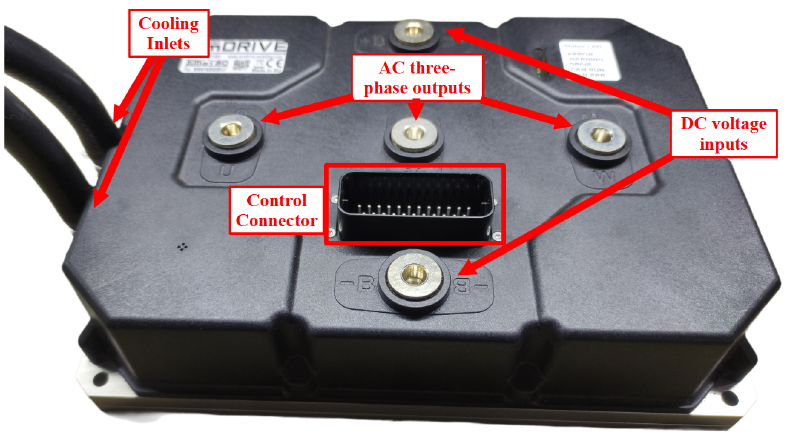
Figure 11. emDrive 500 inverter.